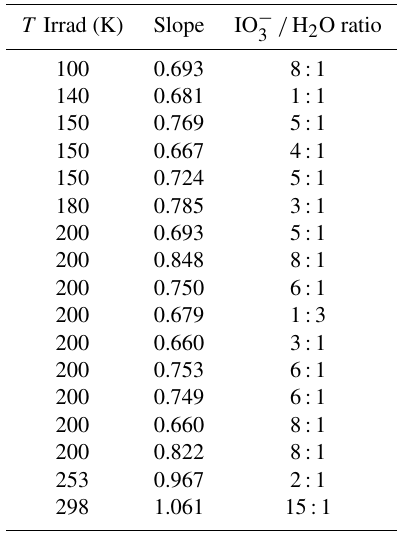
Table 2. Slopes obtained in the linear regression fit of the repre- sentation of the natural logarithm of the integrated intensities (in arbitrary units) of the ν 3 of IO − at different times of irradiation di- 3 vided by that at t = 0 vs. the equivalent calculation for the ν 4 band of NH + for all samples of ammonium iodate at low water propor- 4 tion (see text for details).